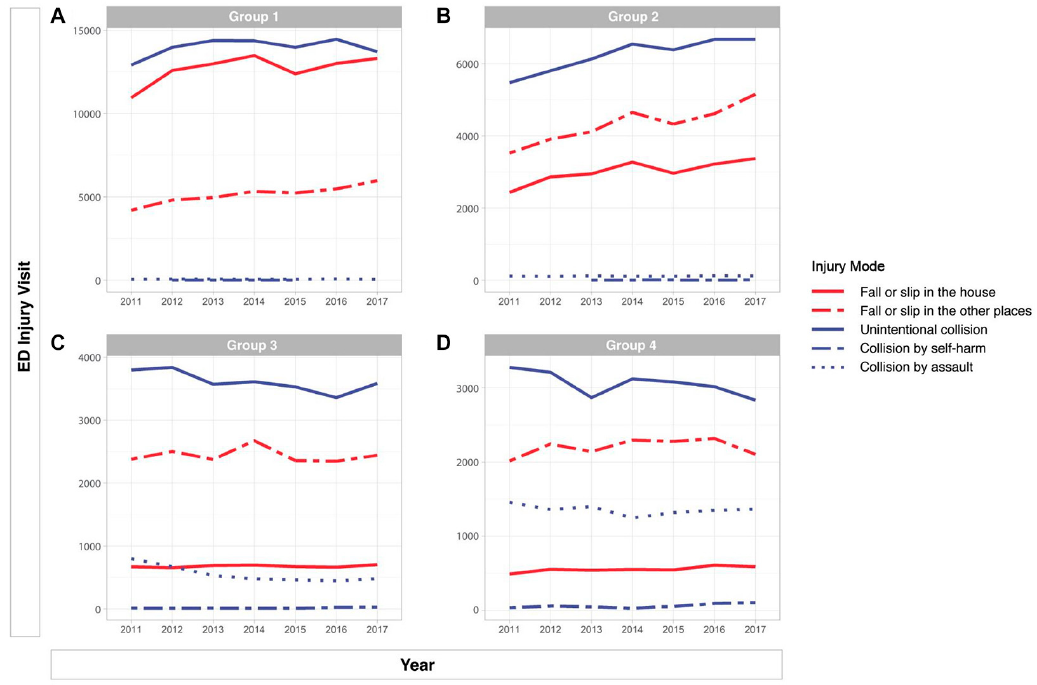
Figure 3. Specific analysis graph of place of injury vs. intention. ( a ) group 1 (0 to 4 years), ( b ) group 2 (5 to 9 years), ( c ) group 3 (10 to 14 years), ( d ) group 4 (15 to 19